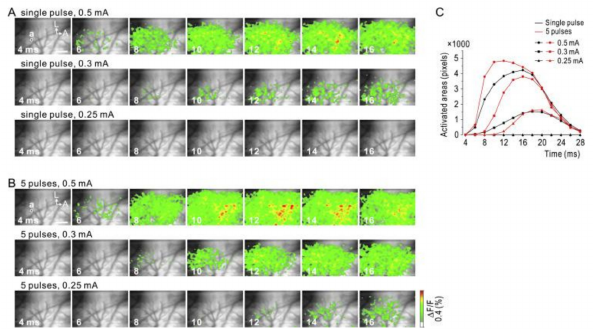
Figure 3. Anodic stimulation via indium tin oxide micro-ECoG. Neural activity captured via fluorescent voltage sensitive dye. ( A ) The white circle (a) indicates a clear electrode used for stimulation. Activation profiles captured after delivering single pulses of current intensity of 0.5, 0.3, and 0.25 mA. ( B ) Duplicate of experiment in ( A ) with a pulse train of five pulses at 500 Hz. ( C ) Comparison of spatial activation spreading due to different stimulation settings. The spatial extent of activity was evaluated by the number of pixels above threshold. A, anterior; L, lateral. Scale bar, 1.0 mm. Reprinted with permission from Reference